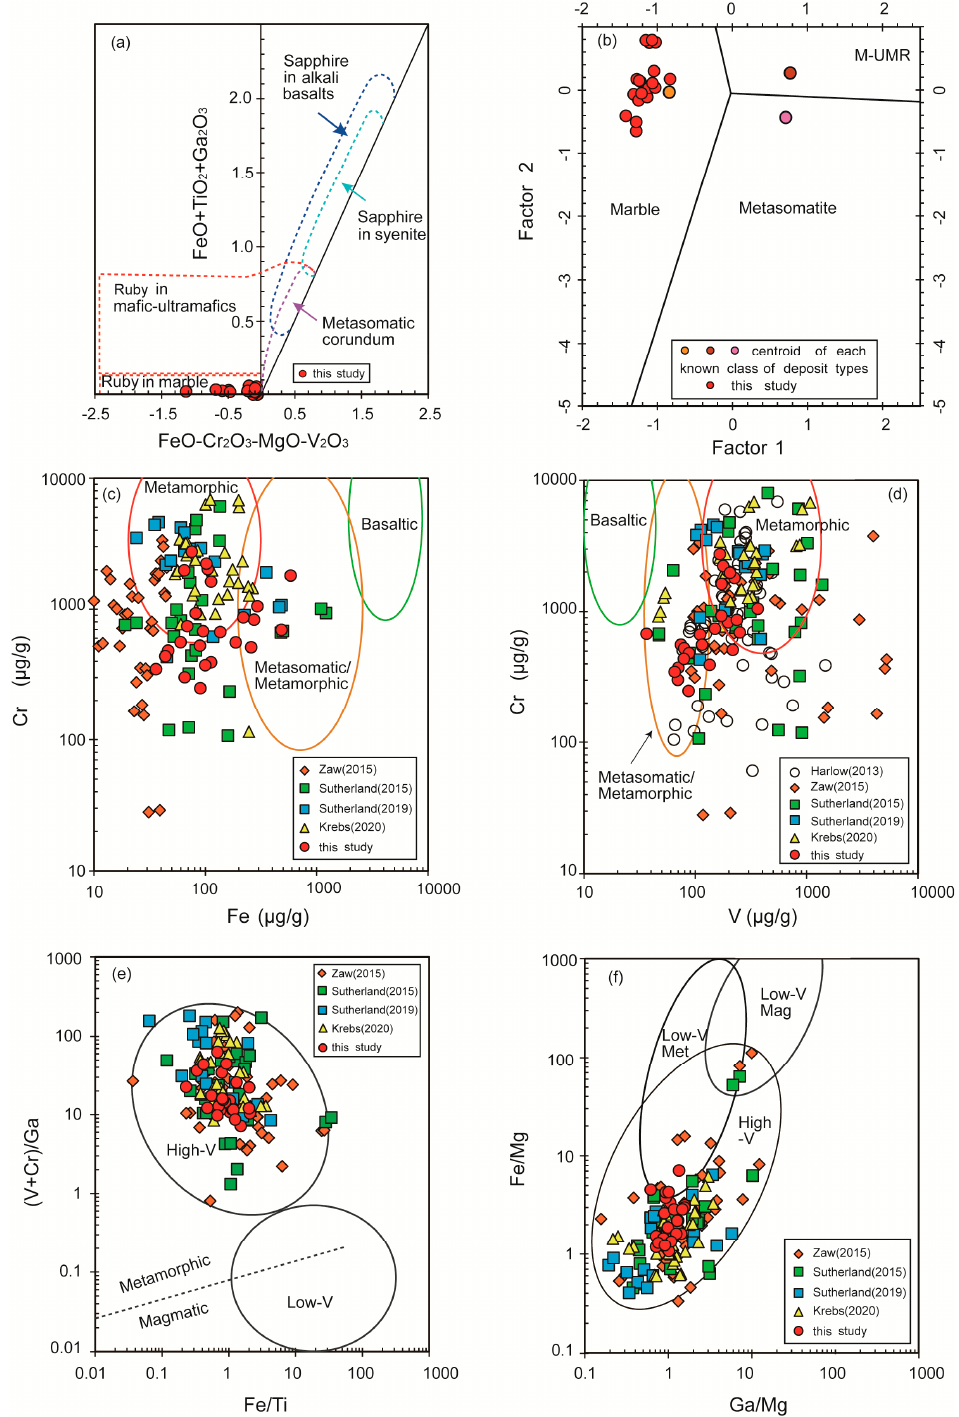
Figure 4. V, Cr, Fe, Ti, Ga, and Mg relationships for ruby from Mogok. ( a ) Discrimination metal oxide plots, with petrological fields after [53], for the studied samples. ( b ) Discriminant factor analysis using oxide concentrations in ruby, modified from [53], for the studied samples. M-UMR: metamorphosed mafic and ultramafic rocks. ( c ) Fe vs. Cr plot. This plot was modified after [4,57]. ( d ) V vs. Cr plot (modified after [4]). ( e ) Fe/Ti vs. (V+Cr)/Ga plot. High-V means high-V metamorphic suite in Mogok and low-V means low-V metamorphic suites in Mogok. This plot was modified after [43]. ( f ) Ga/Mg vs. Fe/Mg plot (modified after [43,50]), Met: metamorphic, Mag: magmatic.